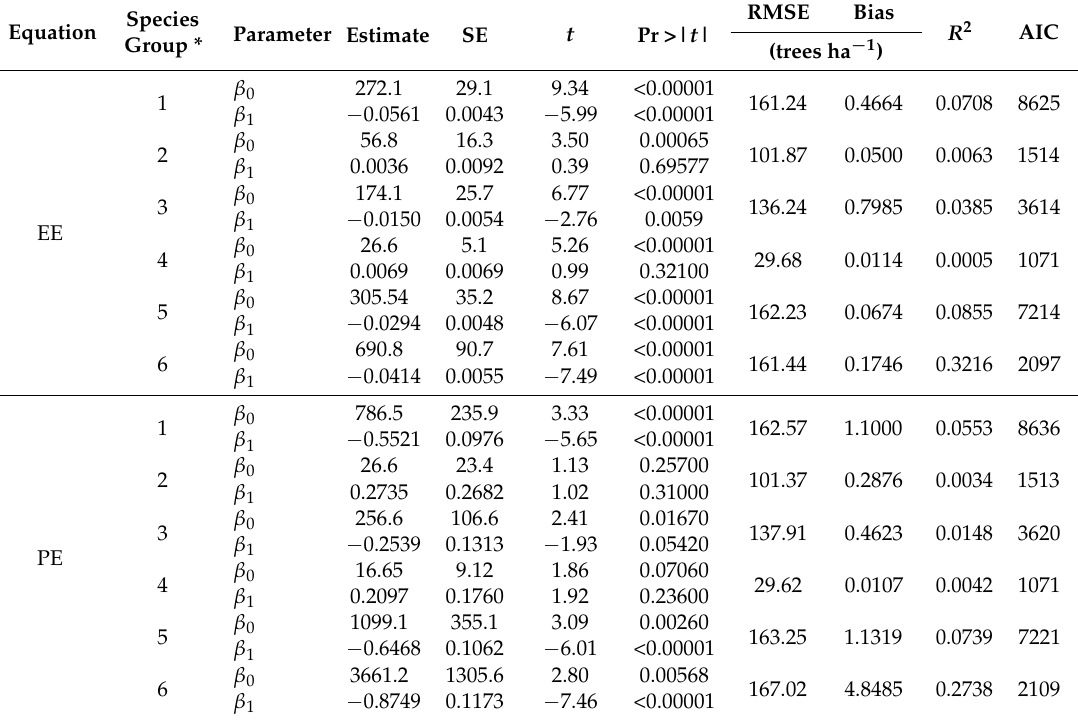
Table 4. Parameter estimates and fitting statistics of the exponential (EE) and potential (PE) equations by species